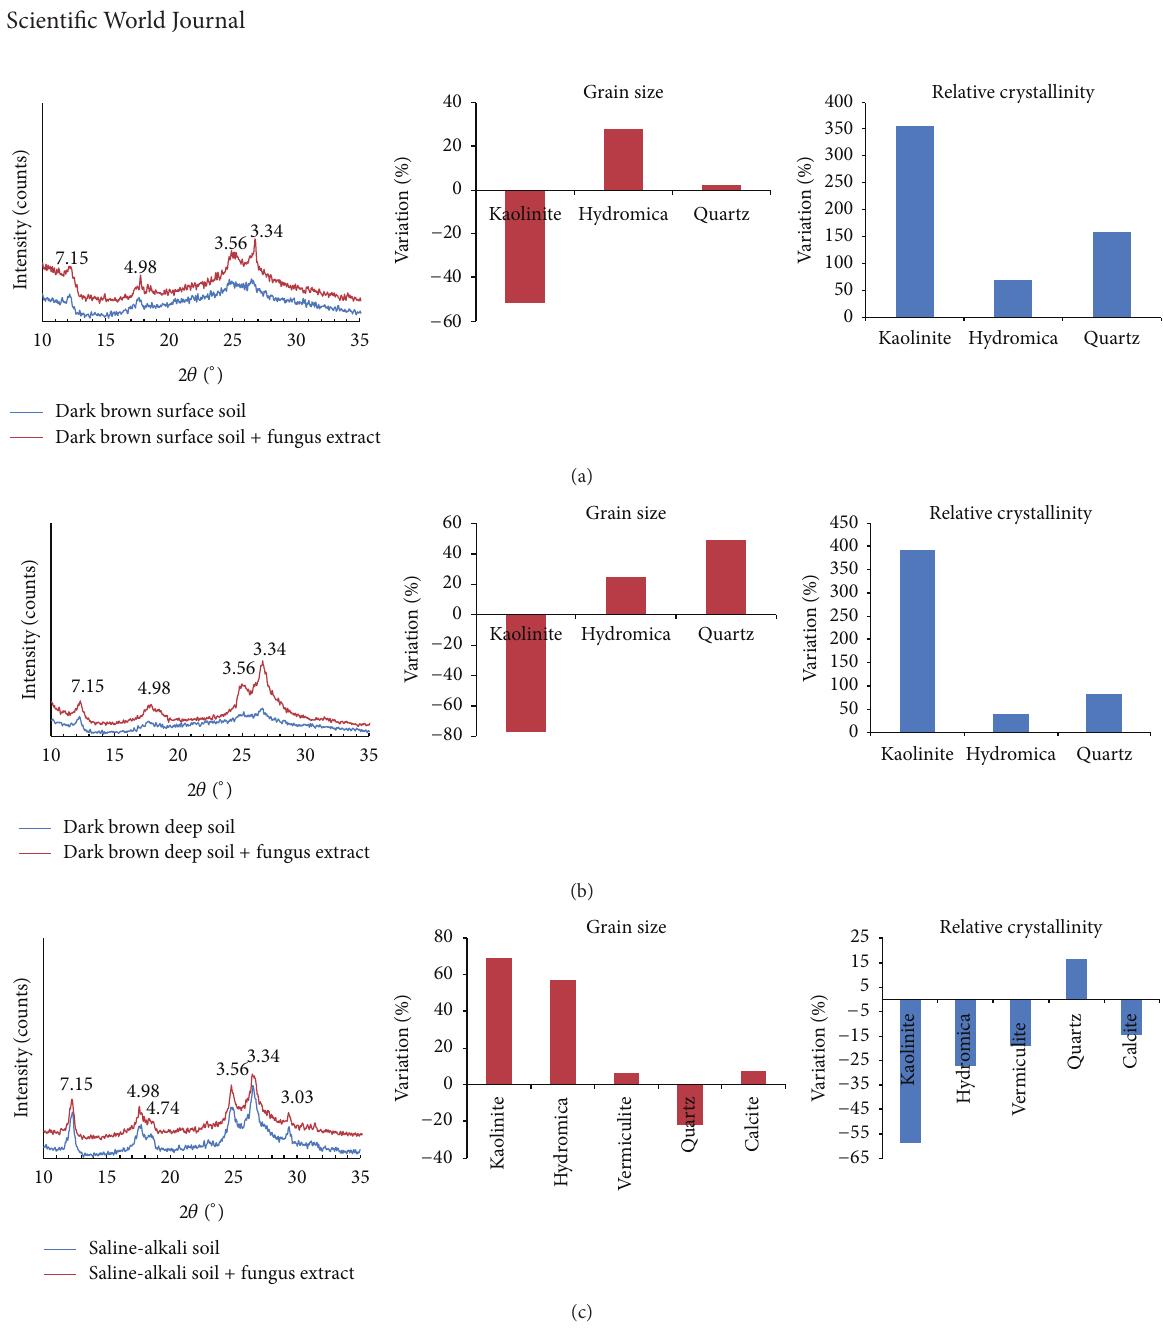
evident in saline-alkali soil than in dark brown forest